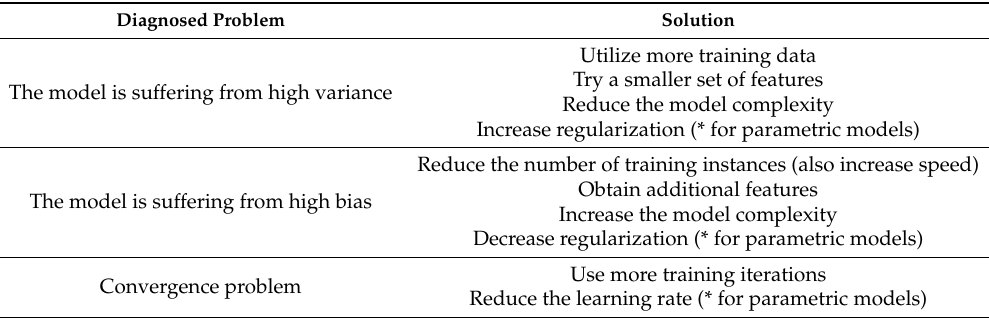
Table 9. Strategies for improving the performance of a learning algorithm. Adapted from [187]. The asterisk (*) denotes solutions that are not applicable to non-parametric learning algorithms such as k nearest neighbors ( k -NN) and decision